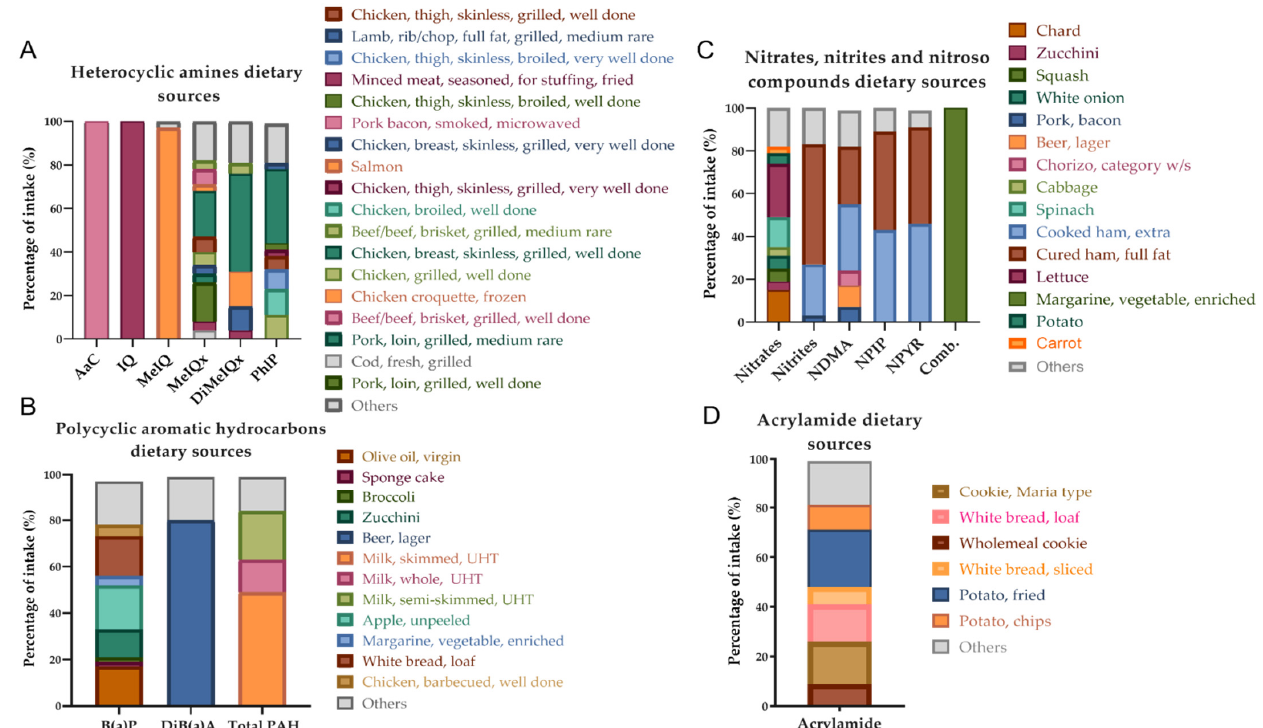
Figure 1. Main dietary sources of xenobiotics in the study sample. ( A ) Heterocyclic amine dietary sources. A α C, amino-alpha-carboline; IQ, 2-amino-3-methylimidazo (4,5,f) quinoline; MeIQ, 2-amino-3,4 dimethylimidazo (4,5,f) quinoline; MeIQx, 2-amino-3,8 dimethylimidazo (4,5,f) quinox- aline; DiMeIQx, 2-amino-3,4,8 trimethylimidazo (4,5,f) quinoxaline; PhIP, 2-amino-1-methyl-6- phenylimidazo (4,5,b) pyridine. ( B ) Polycyclic aromatic hydrocarbon dietary sources. B(a)P, benzo (a) pyrene; DiB(a)A, dibenzo (a) anthracene; Total PAHs, total polycyclic aromatic hydrocarbons. ( C ) Nitrate, nitrite, and nitroso compound dietary sources. NDMA, N -nitrosodimethylamine; NPIP, N -nitrosopiperidine; NPYR, N -nitrosopyrrolidine; Comb., combined nitroso compounds. ( D ) Acry- lamide dietary sources.